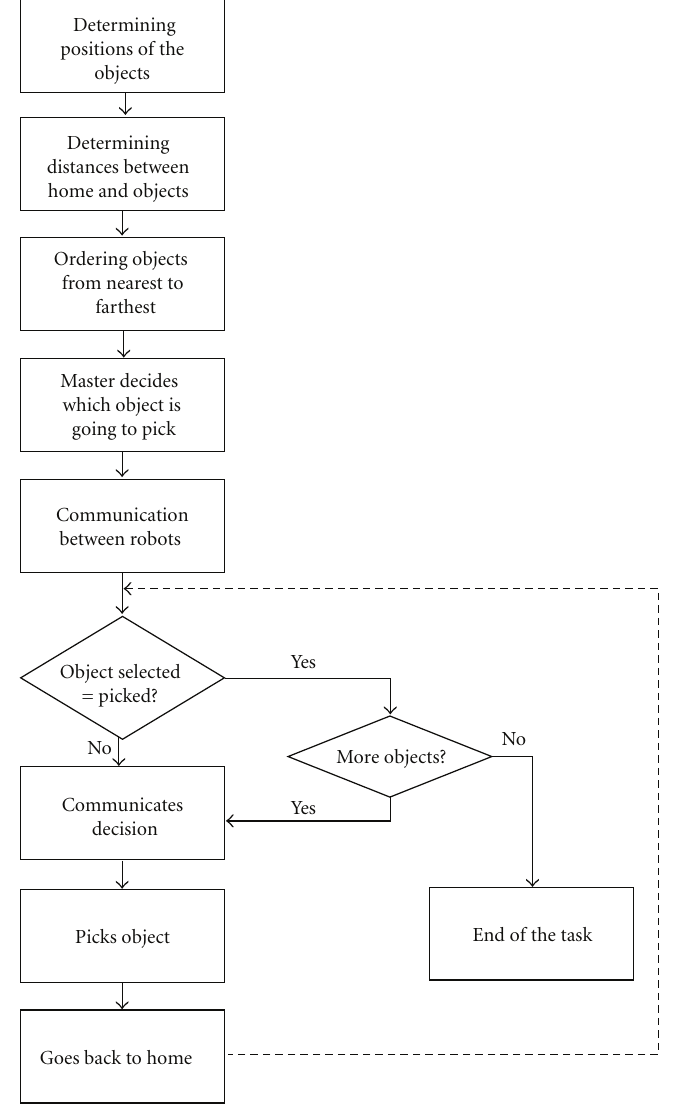
Figure 7: Proposed algorithm for the simple collaborative